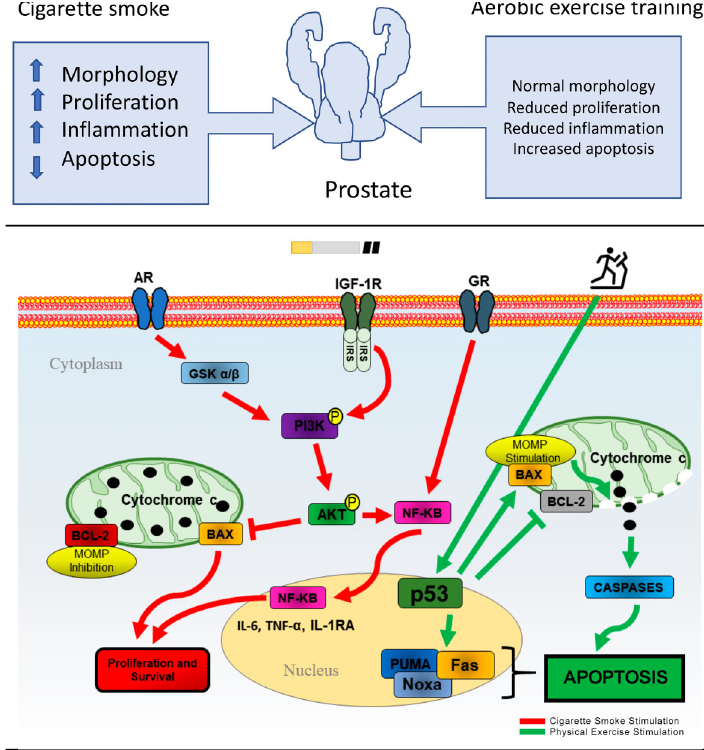
Figure 6. Central role of cigarette smoking on prostate in fl ammation in the progression of dys- regulation and the effects of physical exercise. The prostate is a steroid- and immune-competent organ characterized by complex molecular path- ways considered to be triggers for the dysregula- tion of the prostatic immune system and the development of chronic prostatic in fl ammation. Cigarette smoking promotes hormonal receptor and growth factor activation, which can trigger the phosphorylation of the PI3K and AKT pathways, inhibiting BAX and stimulating nuclear factor- kappa B (NF- k B) activity. AKT prevents cyto- chrome C release and inhibits apoptosis following cigarette smoking. Regular physical exercise can regulate the activation of the PI3K/AKF/NF- k B pathway and promote glucocorticoid receptors (GR) activation by reducing NF- k B and cytokine expression, possibly by p53 activation and sub- sequent BAX upregulation, which leads to apop- tosis and proliferative reduction. AR: androgen receptor; MOMP: mitochondrial outer membrane